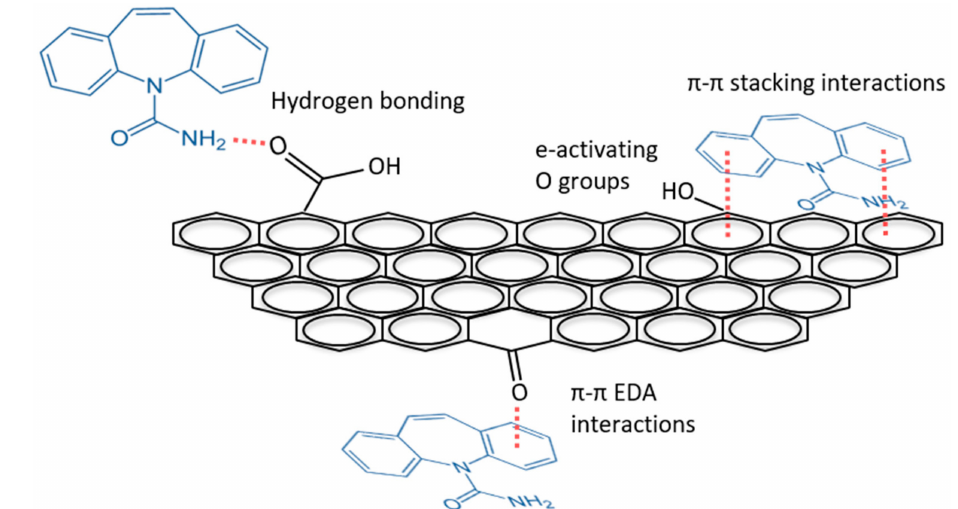
Figure 4. Schematic of the likely sorption mechanisms of carbamazepine on the functionalized graphitic surfaces of